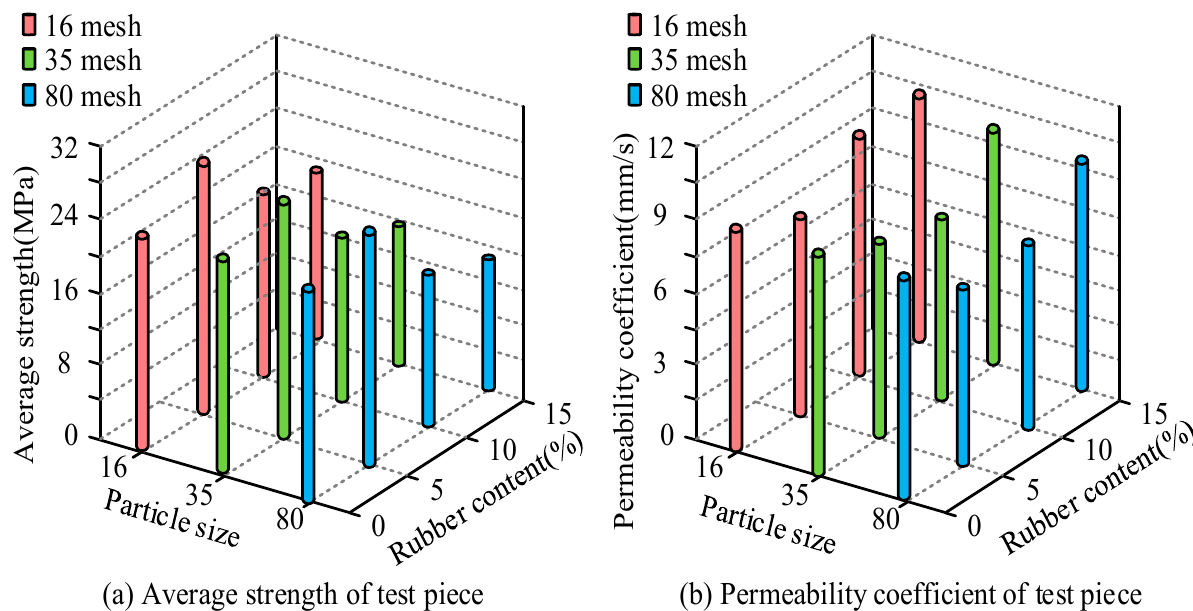
Figure 4. Comparison of properties of test pieces with different rubber particle sizes and contents. ( a ) Average strength of test piece; ( b ) Permeability coefficient of test piece.